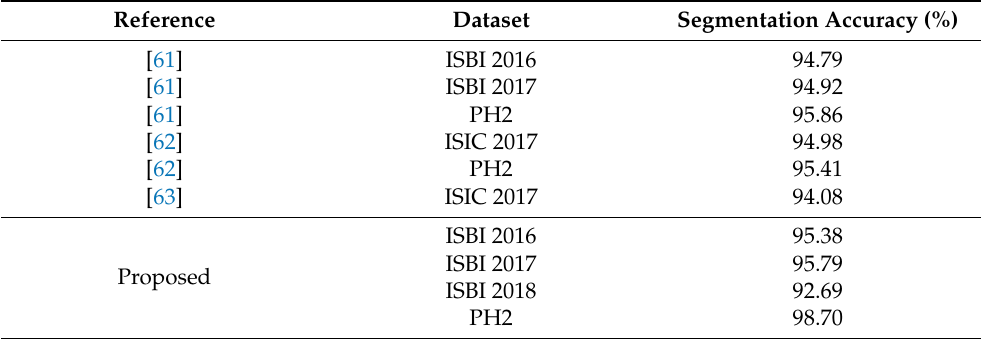
Table 3. Comparison of segmentation accuracy of the proposed method with existing methods.